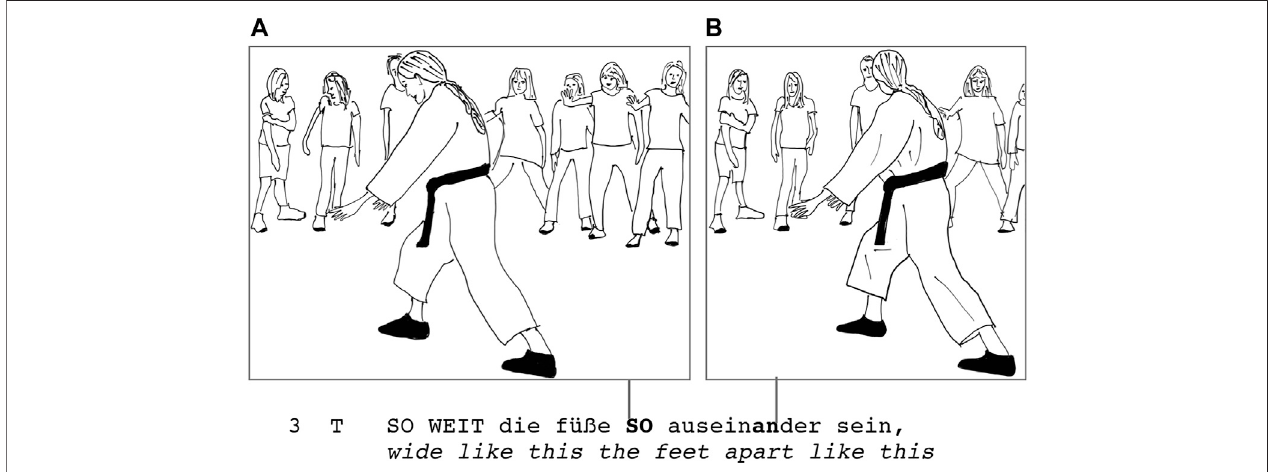
FIGURE 5 | Gaze shift to fl oor, “ so ” + embodied actions (A) , and gaze shift back to addressees with frozen body posture (B)